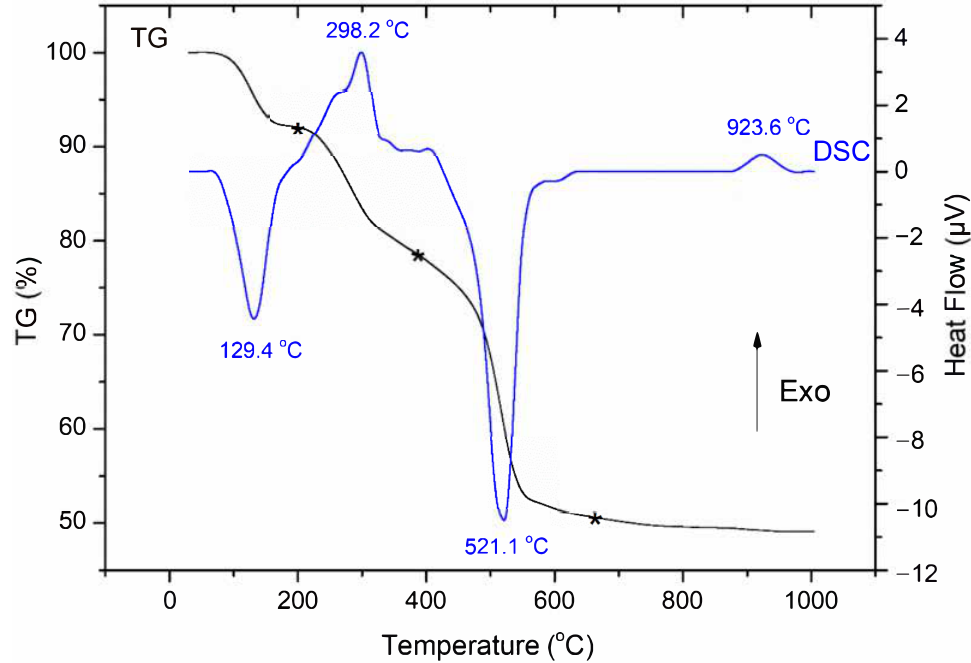
Figure 1. Thermogravimetry–Differential Scanning Calorimetry (TG–DSC) curves of the as-sintering bioactive glass sample.